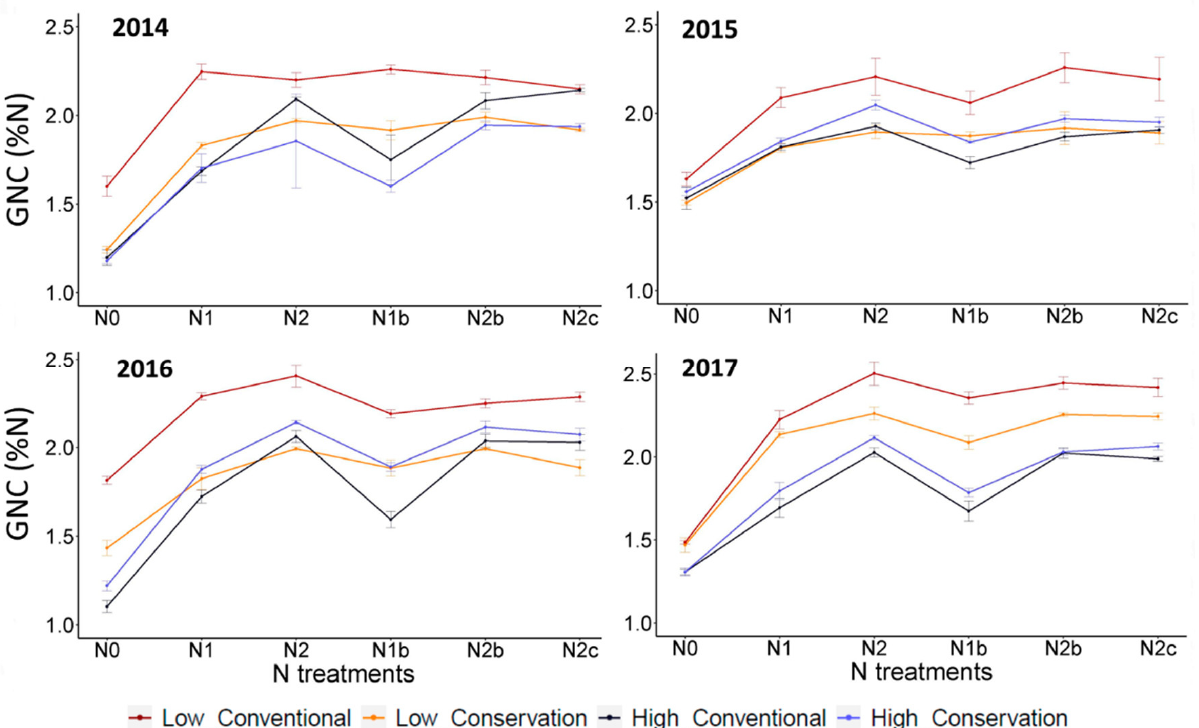
Figure 4. Grain N concentration (GNC, %N) for combined tillage and irrigation factors, for each N treatment and year. Treatment N0 has no fertilizer application; N1 received 125 kg N ha − 1 split one-third at sowing and two-thirds in the first post-plant irrigation; N2 received 250 kg N ha − 1 split as one-third at sowing and two-thirds in the first post-plant irrigation; N1b received 125 kg N ha − 1 split as two-thirds at sowing and one-third in the first post-plant irrigation; N2b received 250 kg N ha − 1 split as two-thirds at sowing and one-third in the first post-plant irrigation, and N2c received 250 kg N ha − 1 applied at sowing. Small bars indicates standard